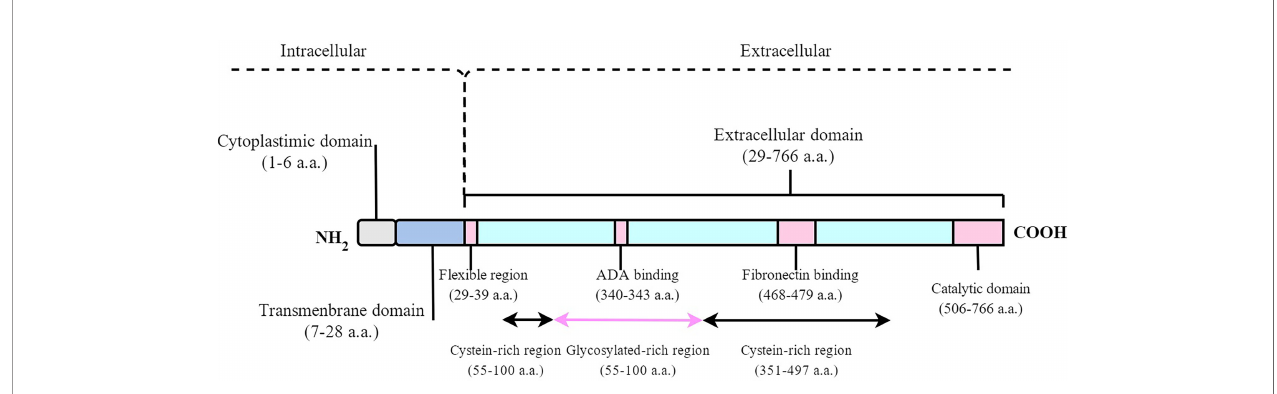
FIGURE 1 | Schematic diagram of the human DPP4 molecule. mDPP4 consists of three domains with 766 residues, including a 6-amino acid N-terminal cytoplasmic domain, a 22-residue hydrophobic transmembrane domain, and an extracellular domain. sDPP4 contains 727 residues without cytoplasmic domain, transmembrane domain, and fl exible